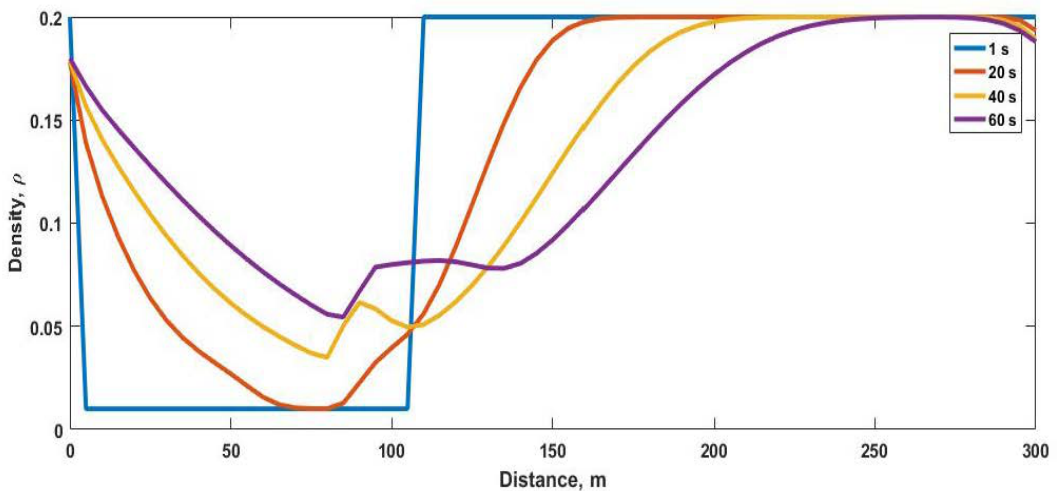
Figure 3. Normalized density with the Payne–Whitham (PW) model on a 300 m circular road with C 0 = 10 at 1 s, 2 s, 4 s and 6